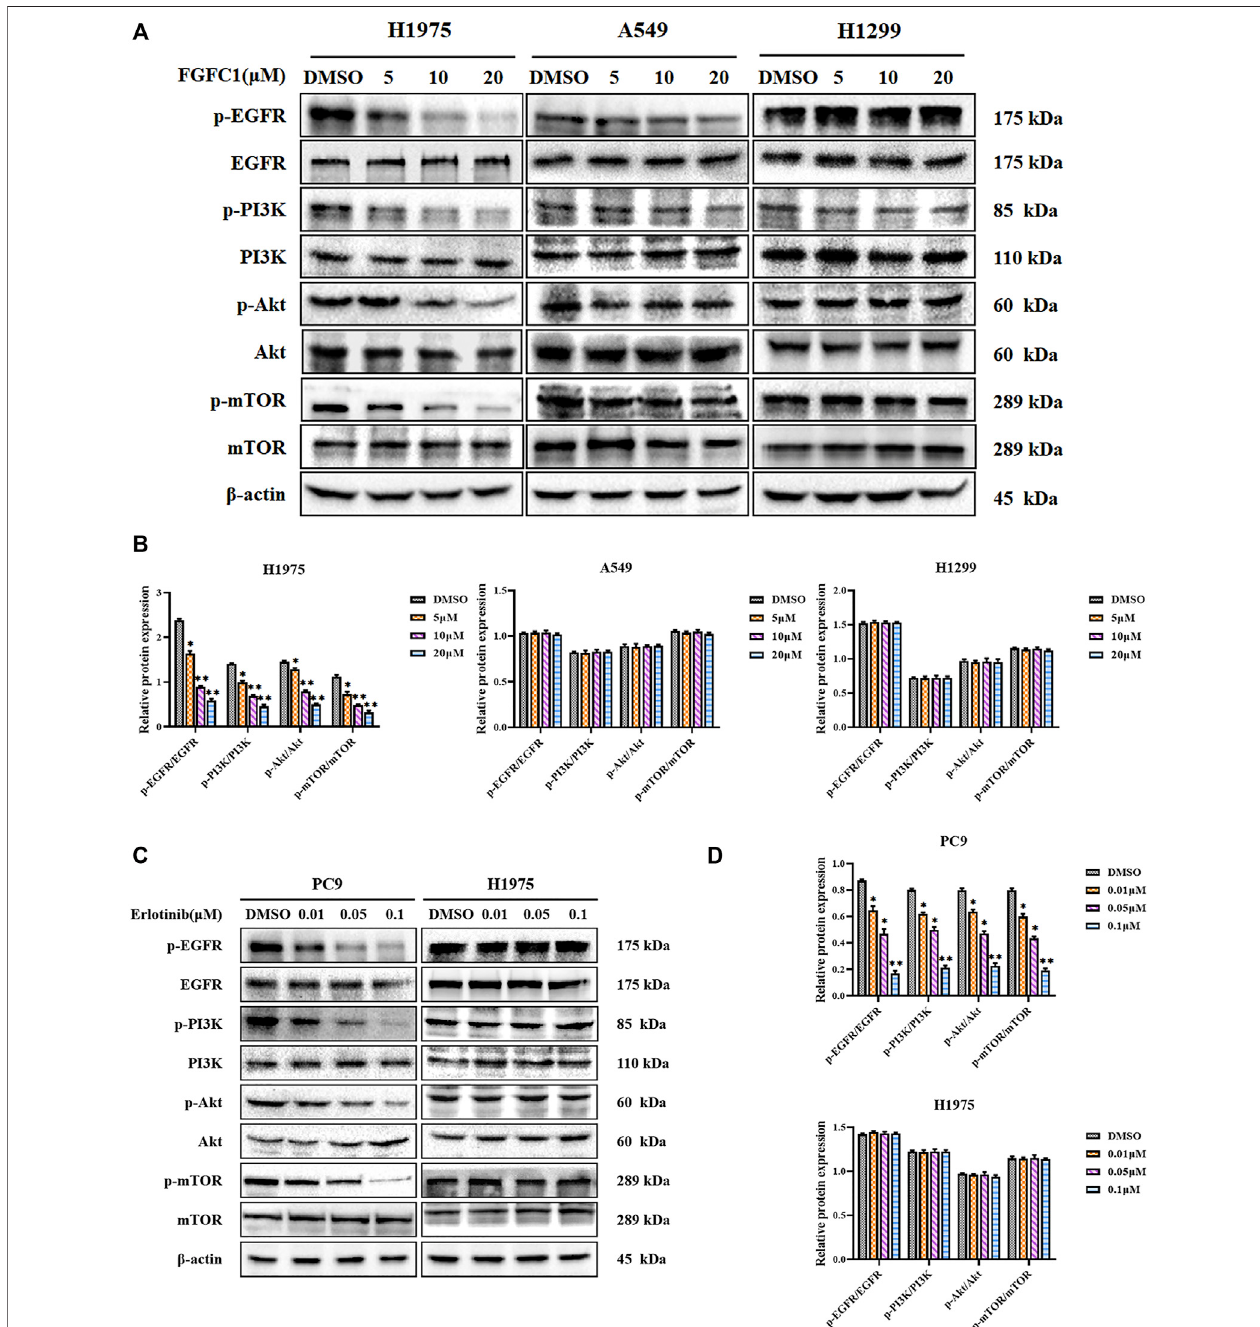
FIGURE 4 | FGFC1 meditated apoptosis through the EGFR pathway against erlotinib-resistant NSCLC cells. (A) FGFC1 remarkably suppressed the phosphorylation of EGFR and its downstream targets in H1975 cells. H1975, A549 and H1299 cells were treated with the indicated concentrations of FGFC1 (0, 5, 10, and 20 μ M) for 24 h. The expression ofp-EGFR, EGFR, p-PI3K, PI3K, p-Akt, Akt, p-mTOR, and mTOR was examined by Western blotting. β -actin was detected as the endogenous loading control. (B) The statistical result of (A) . (C) H1975 and PC9 cells were treated with a range of concentrations of erlotinib (0, 0.01, 0.05, and 0.1 μ M) for 24 h, the cell lysates were subjected to Western blotting with the indicated antibodies. (D) The statistical result of (C) . (E) H1975 cells were treated with FGFC1 (10 μ M) and LY294002 (20 μ M) alone or in combination for 24 h. The expression of p-EGFR, EGFR, p-PI3K, PI3K, p-Akt, Akt, p-mTOR, mTOR, cleaved- caspase3, cleaved-PARP, Bax, and Bcl-2 was evaluated by Western blotting. β -actin was detected as the endogenous loading control, accordingly. (F) The statistical result of (E) . (G) H1975 cells were treated with FGFC1 (10 μ M) and LY294002 (20 μ M) alone or in combination for 24 h. Intra cellular ROS were measured by fl ow cytometry after 10 μ M DCFH-DA staining. (H) Statistical analysis of the percentage of ROS generation. (I) Docking score ofFGFC1 with EGFR T790M/L858R and EGFR WT . (J) The binding mode of FGFC1 docked into EGFR T790M/L858R and EGFR WT , respectively. Data shown were representative of three independent experiments. All data were represented as the means ± SD for at least three independent experiments. ( *p < 0.05 and **p < 0.01 vs the DMSO control).